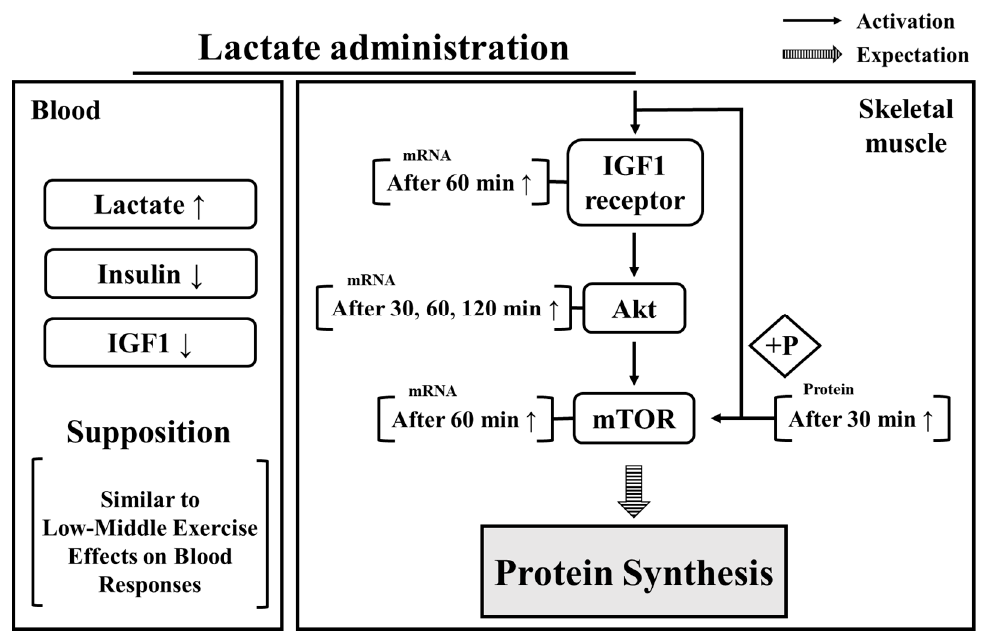
Figure 6. Effect of lactate administration on blood parameters and skeletal muscle. IGF: insulin growth factor 1. IGF receptor: insulin growth factor receptor. Akt: protein kinase B. mTOR: mammalian target of rapamycin.